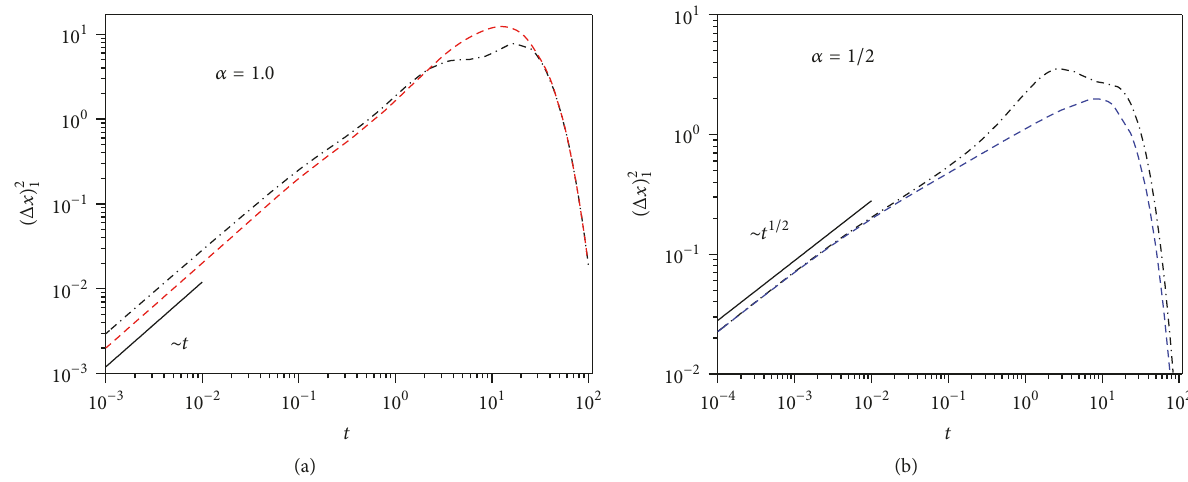
Figure 2: Behavior of the mean square displacement for species 1 versus 𝑡 . In (a) the black dashed-dotted line corresponds to the case 𝜅 = 1 with 𝜏 = 1 and the red dashed line represents the case 𝜅 = 0 . In (b), the black dashed-dotted line is the cases 𝜅 = 1 and 𝜏 = 1 and the blue dashed line corresponds to the case 𝜅 = 0 . In all cases, we used K 1 = 1 and 𝑘 = 0.1 . We also use straight lines to evidence the asymptotic behavior for small times which for 𝛼 = 1 is usual and for 𝛼 ̸= 1 is anomalous.